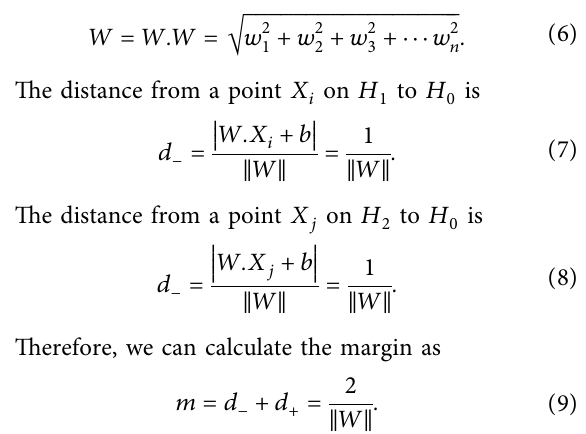
Figure 5: Mapping data from two-dimensional space to three- dimensional